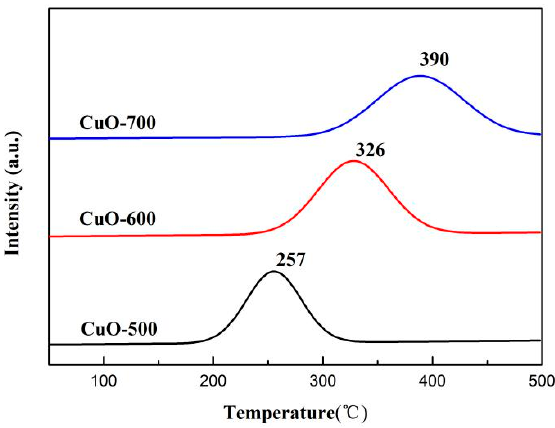
Figure 6. H 2 -TPR profiles of pure CuO catalysts.